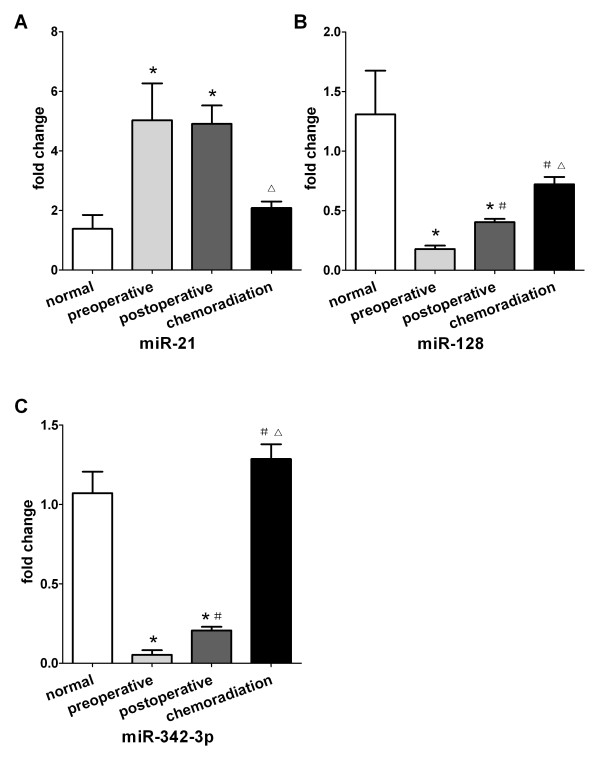
The relationship between the plasma levels of miR-21, miR-128 and miR-342-3p and classification of glioma. (A) Levels of miR-21 were up-regulated in grade II in comparison with control cohorts and much higher in grade III cohorts than in grade II cohorts, however there were no significant difference between glioblastoma patients (grade IV) and grade III cohorts or grade II cohorts. (B) Levels of miR-128 were significantly lower in grade II cohorts than in normal cohorts, much lower in grade III cohorts and in glioblastoma patients than in grade II cohorts (P < 0.001), there were no significant difference between glioblastoma patients and grade III cohorts. (C) Levels of miR-342-3p were significant difference among all formation. *P<0.008 in comparison with normal, #P < 0.008 in comparison with glioma II, △P < 0.008 in comparison with glioma III.